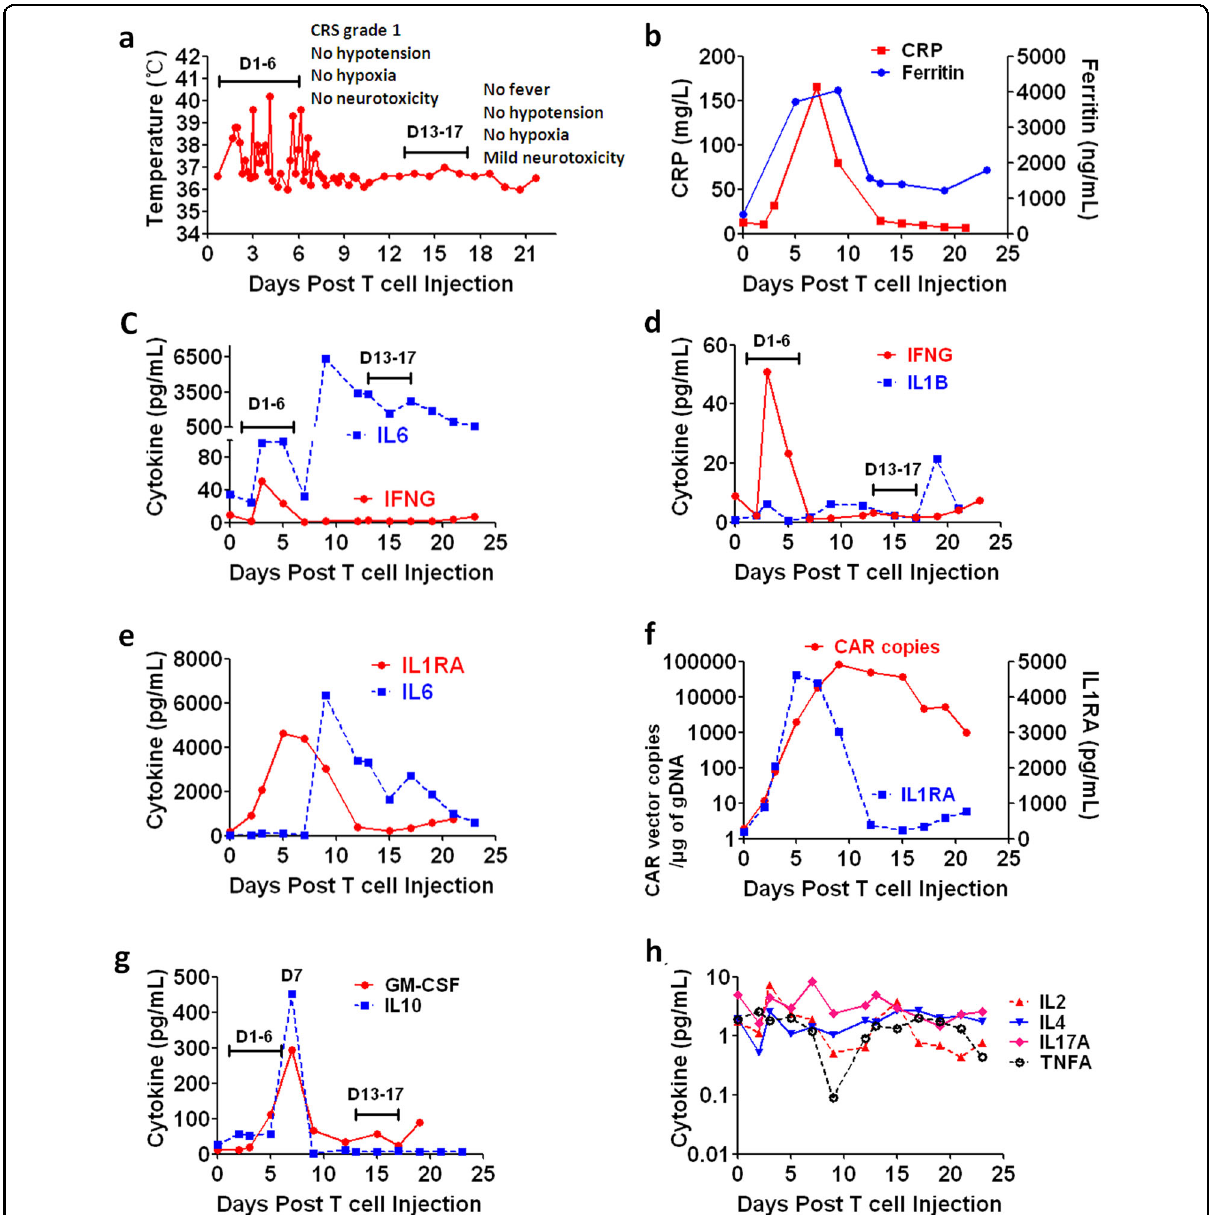
Fig. 6 Sustained high level of serum IL6 was associated with neurotoxicity in the patient (#1 in Table 1) after typical grade 1 CRS ended. a The changes of body temperature after infusion. b Levels of CRP and Ferritin in peripheral blood. c Changes of IFNG versus IL6. d Changes of IFNG vs IL1B. e Changes of IL1RA vs IL6. f Kinetics of CAR vector copies vs IL1RA changes. g Changes of GM-CSF and IL10. h Changes of IL2, IL4, IL17A, and